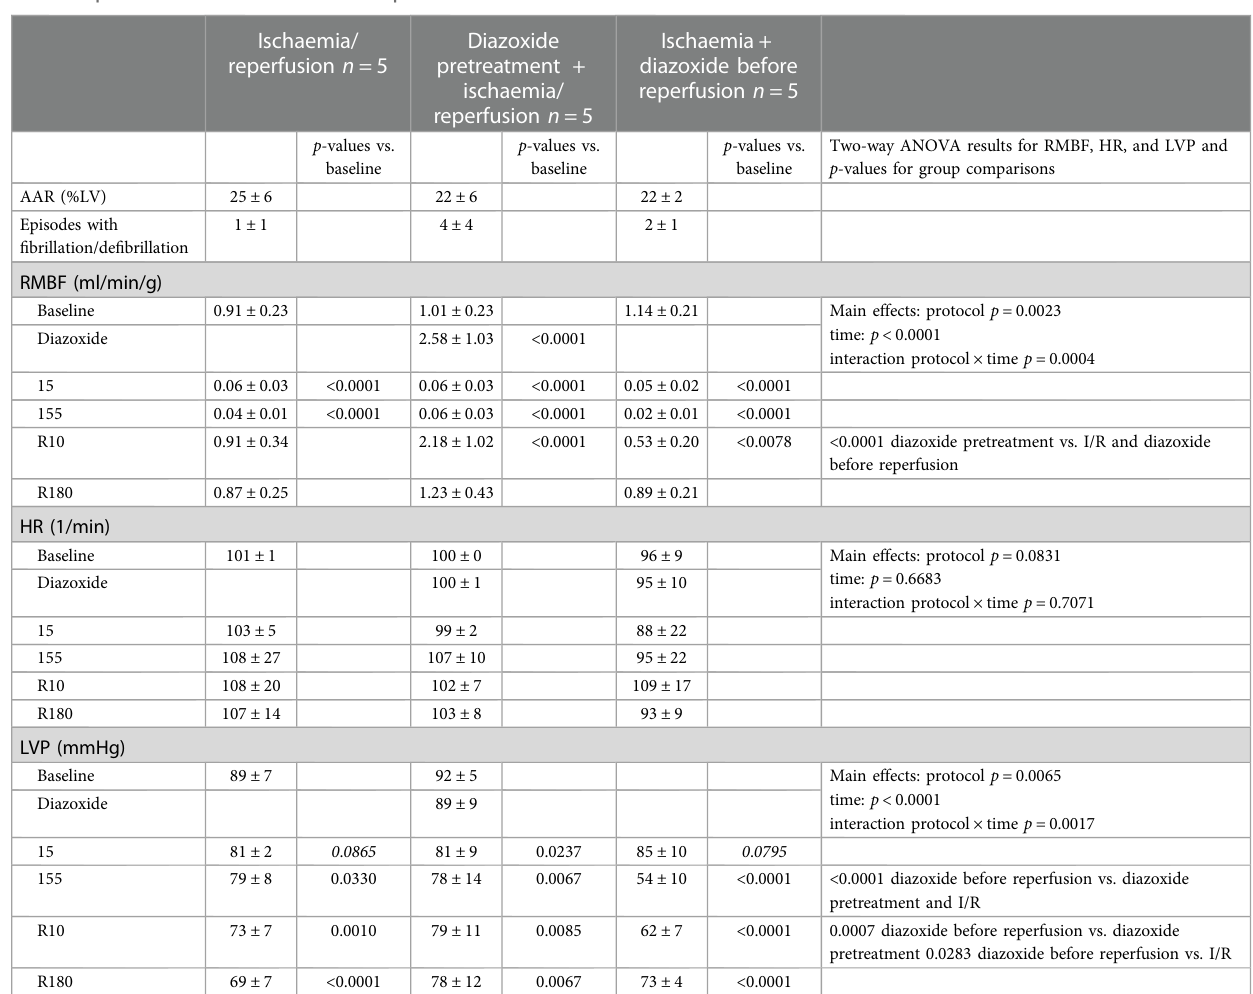
TABLE 1 Area at risk, regional myocardial blood fl ow, heart rate, and left ventricular pressure in pigs undergoing ischaemia/reperfusion without and with diazoxide pretreatment or diazoxide before reperfusion.